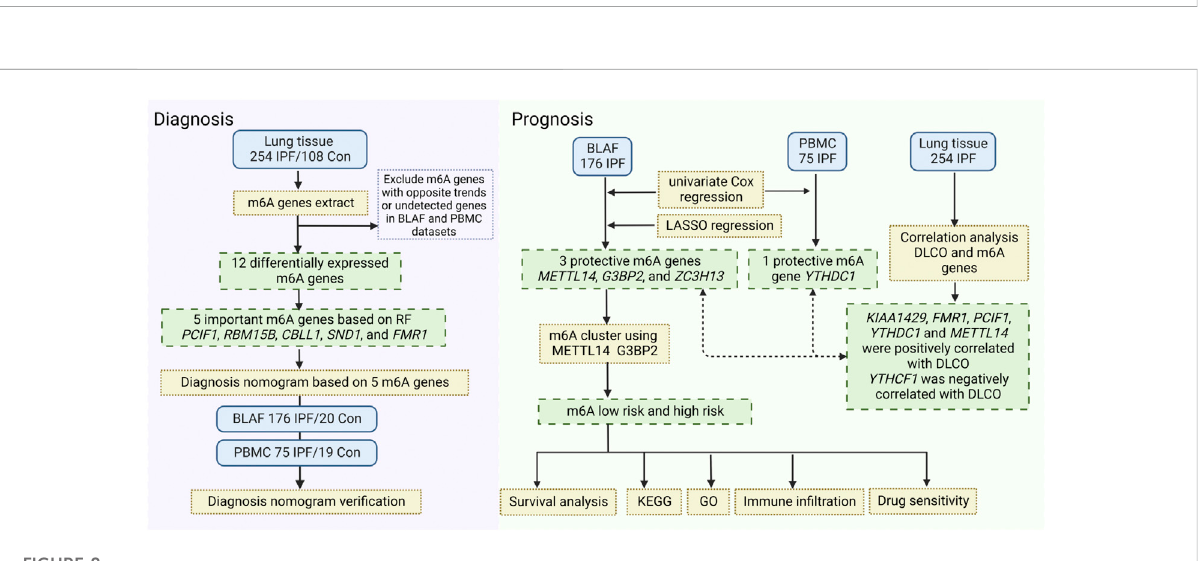
FIGURE 8 The fl ow chart of the contents of the